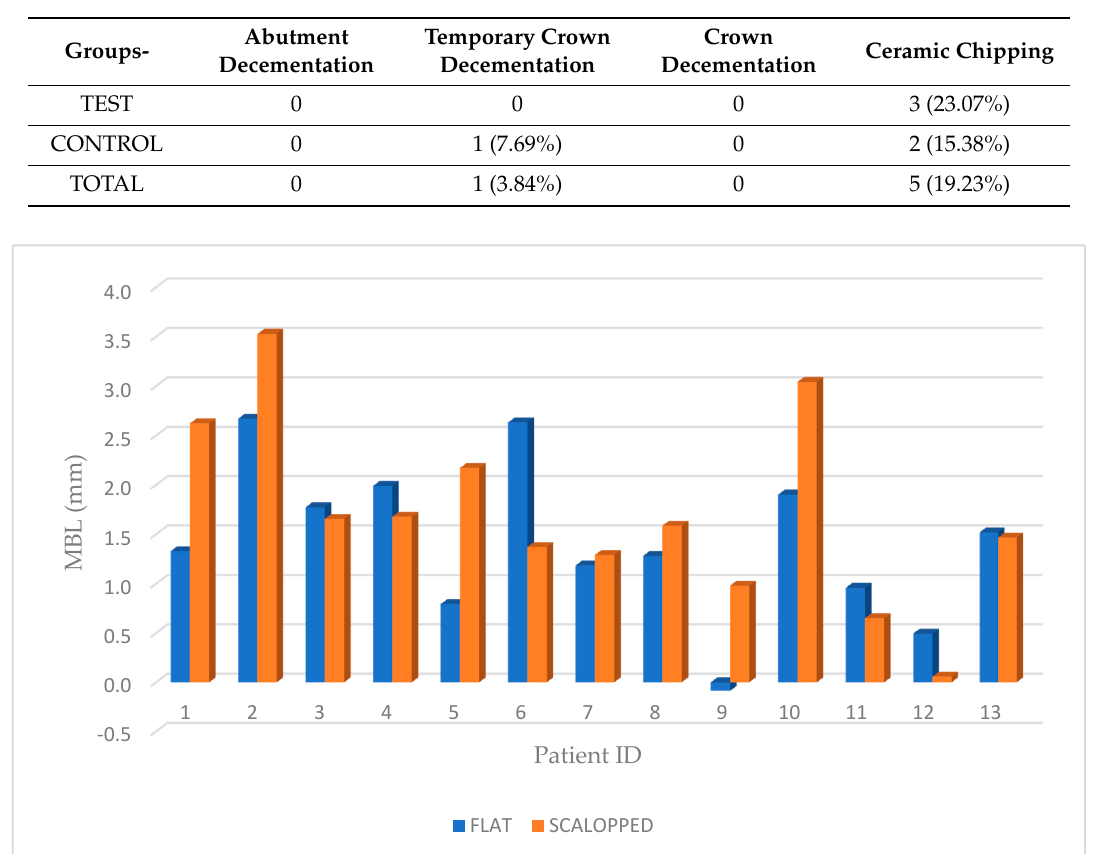
Figure 4. Graphic representation of marginal bone level of both groups at T0, where no statistically significant difference was shown between the test (scalloped) and control (flat) groups (P = 0.2325).